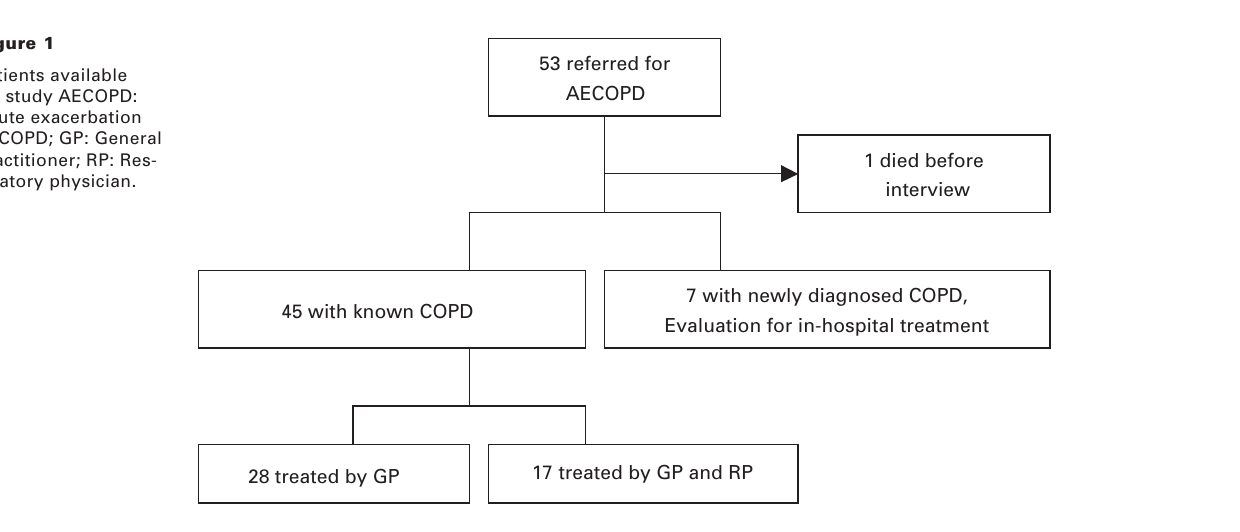
Patients available for study AECOPD: Acute exacerbation of COPD; GP: General practitioner; RP: Res- piratory